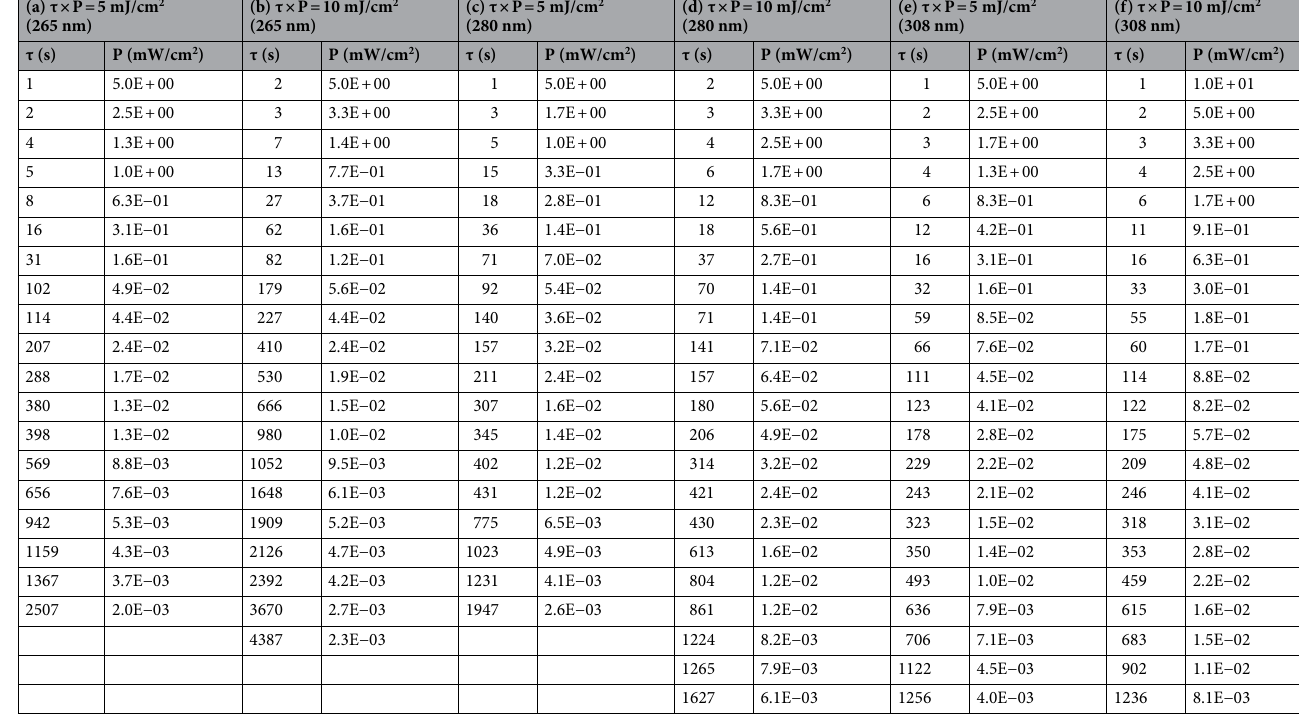
Table 1. Combinations of irradiation duration τ (s) and irradiance P (mW/cm 2 ) used to obtain the inactivation ratios plotted in Fig.